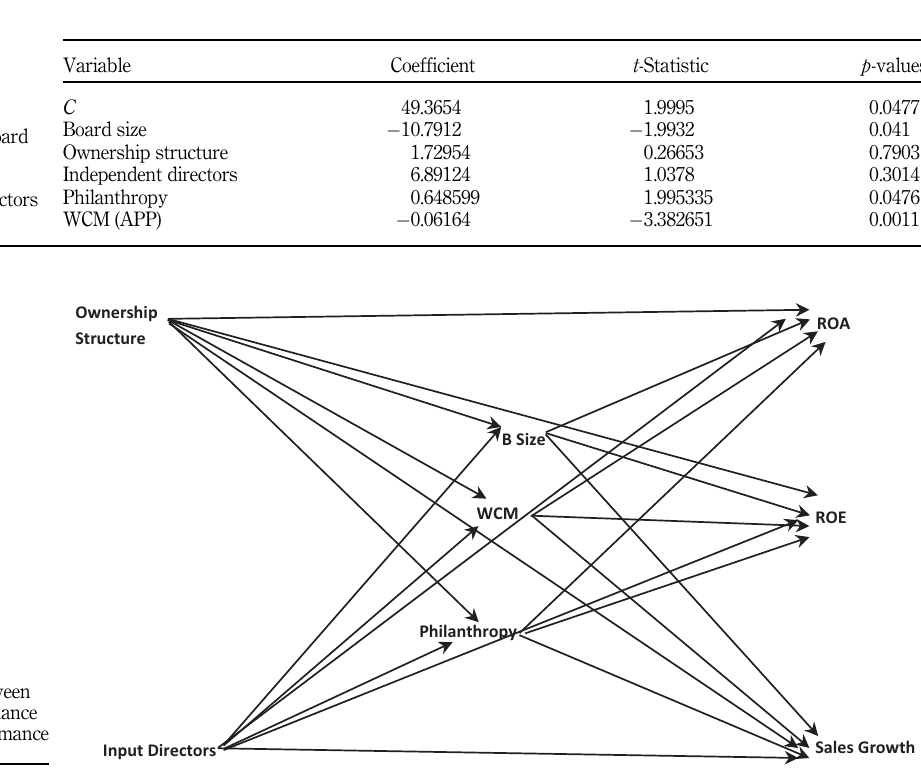
Figure 1. Theoretical framework: relationship between corporate governance and firms ’